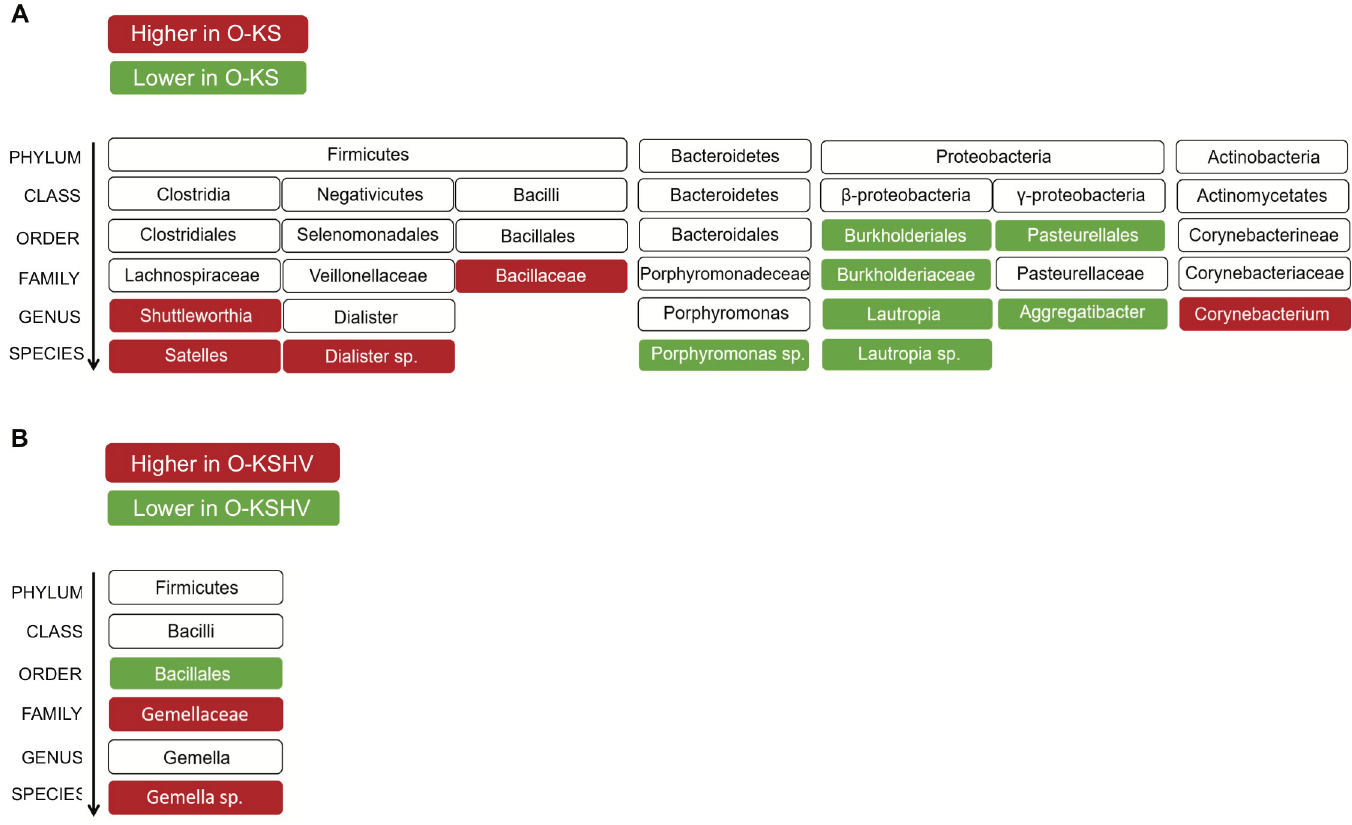
Fig 5. Phylogenetic links among the OTUs altered in HIV/KSHV-coinfected individuals who developed oral KS (A), or with oral cell-associated KSHV DNA